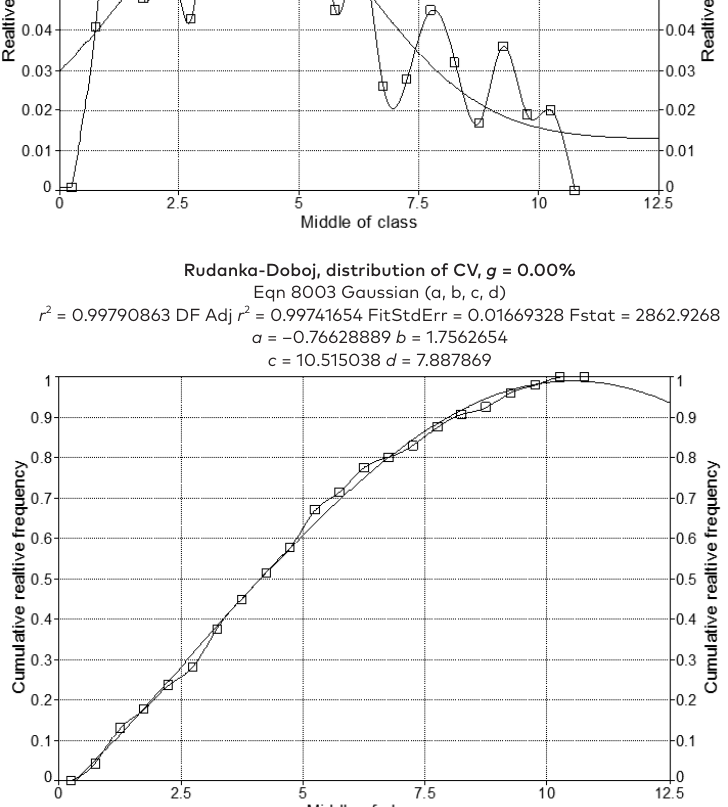
Figure 3. Empirical distribution analysis of PCE